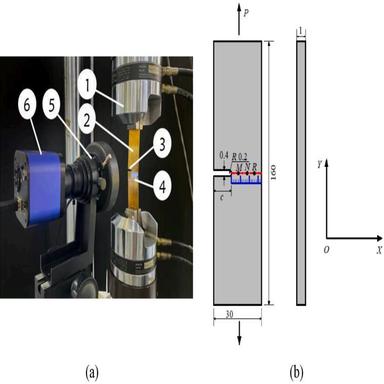
Experimental procedures during the uniaxial tensile test: (a) experimental apparatus; (b) the schematic of specimens with the prefabricated U-notch and the marked points. ①MTS-858/2.5 T servo-hydraulic uniaxial test machine; ②The specimens; ③The prefabricated U-notch; ④The ruler; ⑤Microscopic lens; ⑥Digital CMOS camera integrated with the measurement system operated by PC and FlexTest console.